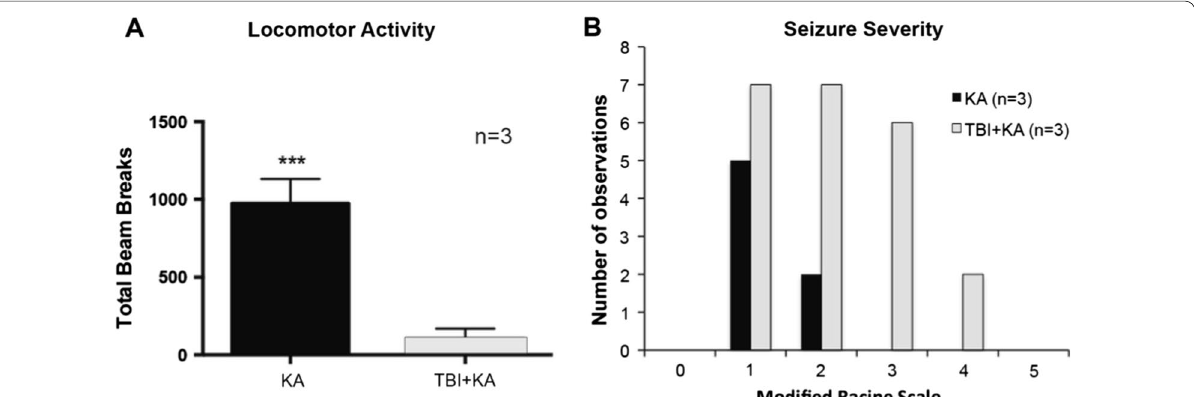
Fig. 1 A sub‑convulsvie dose of kainic acid (KA) impedes locomotion and increases seizure severity 72 h after TBI. a Beam break number is significantly higher in control mice (black bar) compared to mice exposed to TBI (gray bar). b Control mice (black bars) are more resistant to kainic acid‑induced seizures than blast‑exposed mice (gray bars)